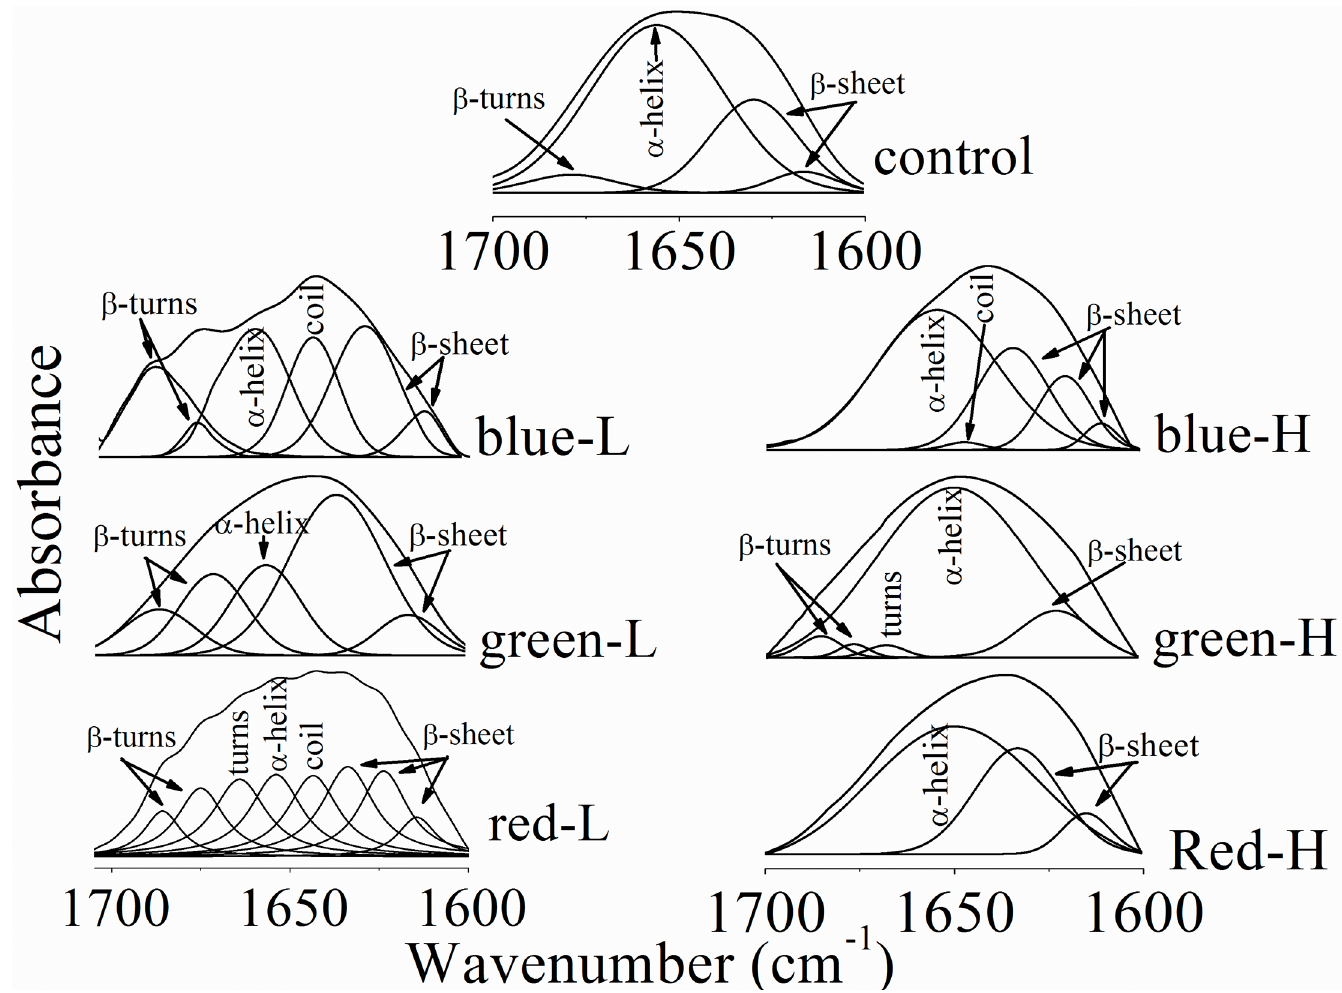
Fig 3. Protein secondary structure components of corneas after exposure to different color intensities. https://doi.org/10.1371/journal.pone.0196827.g003 cm -1 ) are detected in all exposed groups to low and high lux. The changes in the protein sec- ondary structure of the red-L group were associated with the formation of extremely strong